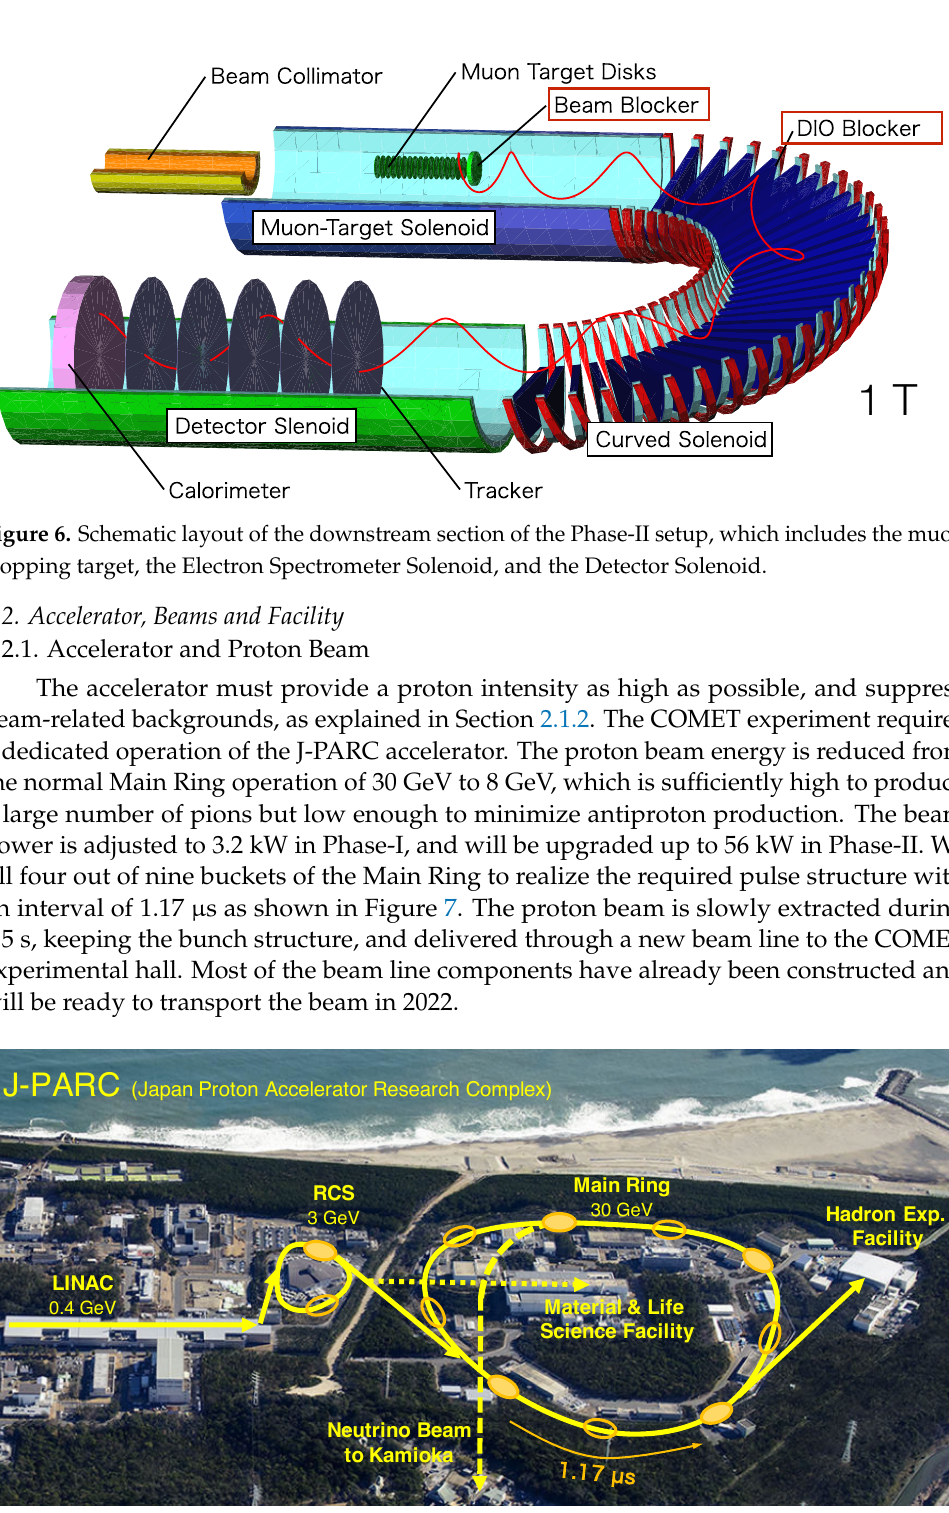
Figure 7. A bird’s eye view of the J-PARC accelerator facility. COMET takes place in the Hadron Experimental Facility. The orange ovals shown on RCS and Main Ring represent the proton bunch structure. The solid and open ovals indicate filled and empty proton bunches, respectively, in the COMET 8-GeV operation. (The photo was provided by the J-PARC